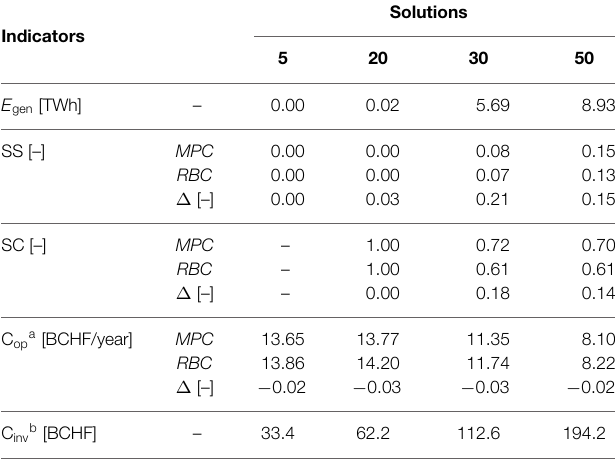
TABLE 3 | National impact of